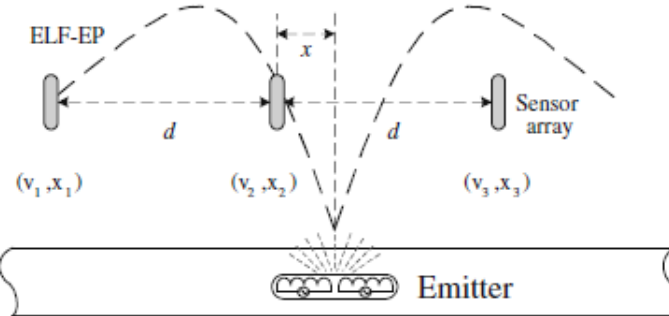
Figure 24. The distribution of ELF sensors outside a pipeline. Reprinted from Mechatronics, Volume 19, Qi, H.; Zhang, X.; Chen, H.;Ye, J. Tracing and Localization System for Pipeline Robot, Page 76–84, Year 2009 with permission from Elsevier